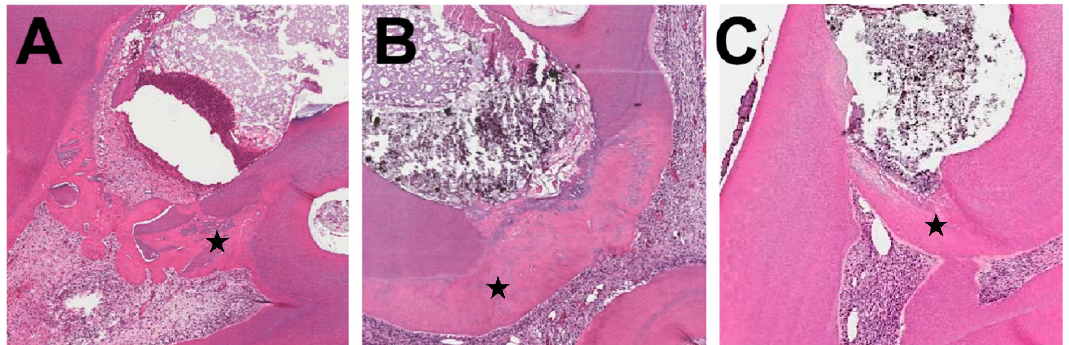
Figure 4. Histologic features of maxillary first molars subjected to pulp exposure and capped with ( A ) iloprost, ( B ) MTA, and ( C ) MTA-iloprost at week four. H&E stain ×200 magnification. The star indicates tertiary dentin.